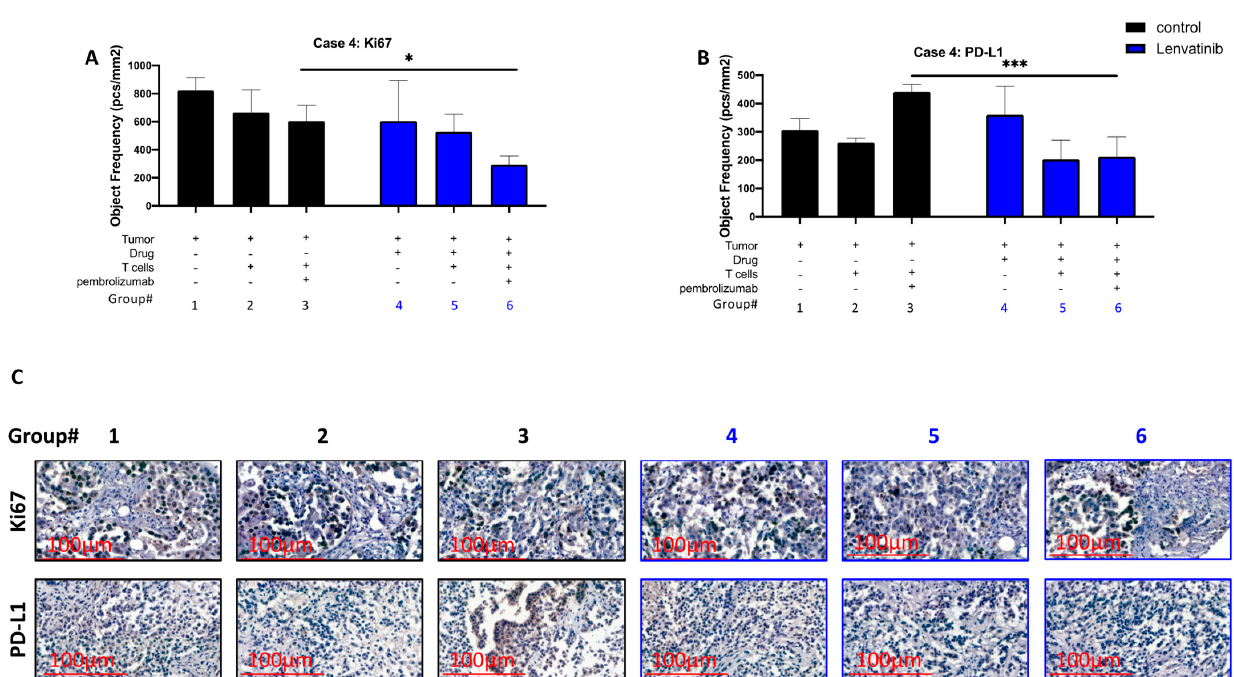
Figure 7. Correlation between the multikinase inhibitor (lenvatinib) and the immune checkpoint inhibitor (pembrolizumab) treatments. A 3 ‐ dimensional (3D) ex vivo assay was performed as an i ‐ TEVA assay on patient 4 ′ s tumor and T cells: ( A , B ) lenvatinib (blue) was the experimental test, and the control (black) was untreated. From the 3D ex vivo assay, 5 ‐μ m FFPE sections were stained either for Ki67 (proliferation marker) or PD ‐ L1 expression. A two ‐ way ANOVA multiple comparisons test was performed among the groups for each patient individually, with three biologically independent counts in each group. * p = 0.0498; *** p = 0.0007. All statistical data analysis was performed using GraphPad Prism, version 8.0.2; ( C ) This figure shows representative pictures for each group from 1 to 6. Pictures were captured using CaseViewer 40× magnification at 300 dpi; scale bar is located at the left bottom corner, 100 μ m (red).